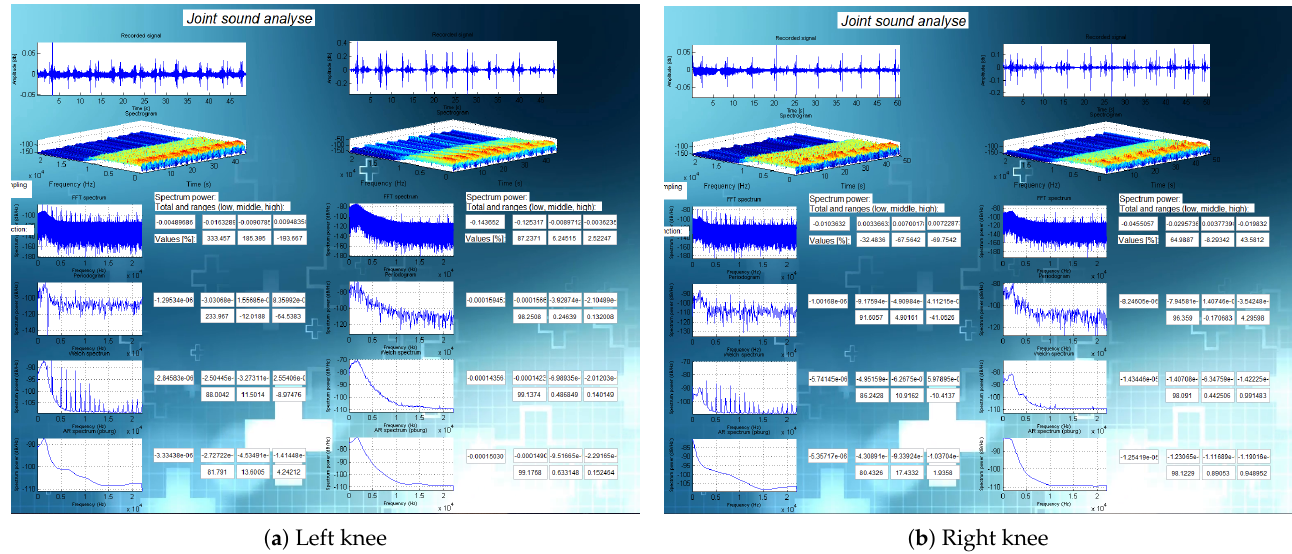
Figure A10. Analysis for subject 10.